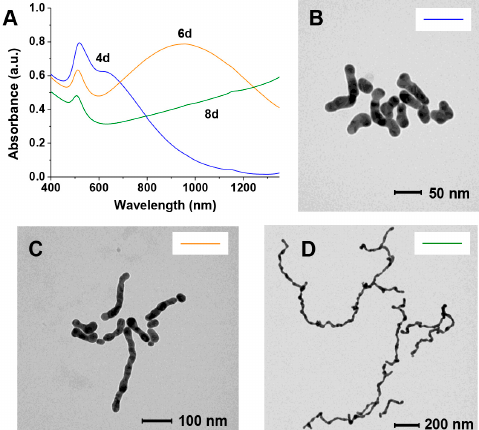
Figure 6. Absorption spectra ( A ) and TEM images of samples collected after ( B ) 4 days, ( C ) 6 days, or ( D ) 8 days and passivated with thiol 2 . The color of the line in the inset in each TEM image links it to the corresponding UV–Vis spectrum in A. Table 1. Dimensions of the nanowires after stopping the AuNPs aggregation and fusion at different times and the maximum of the longer-wavelength plasmon resonance band.